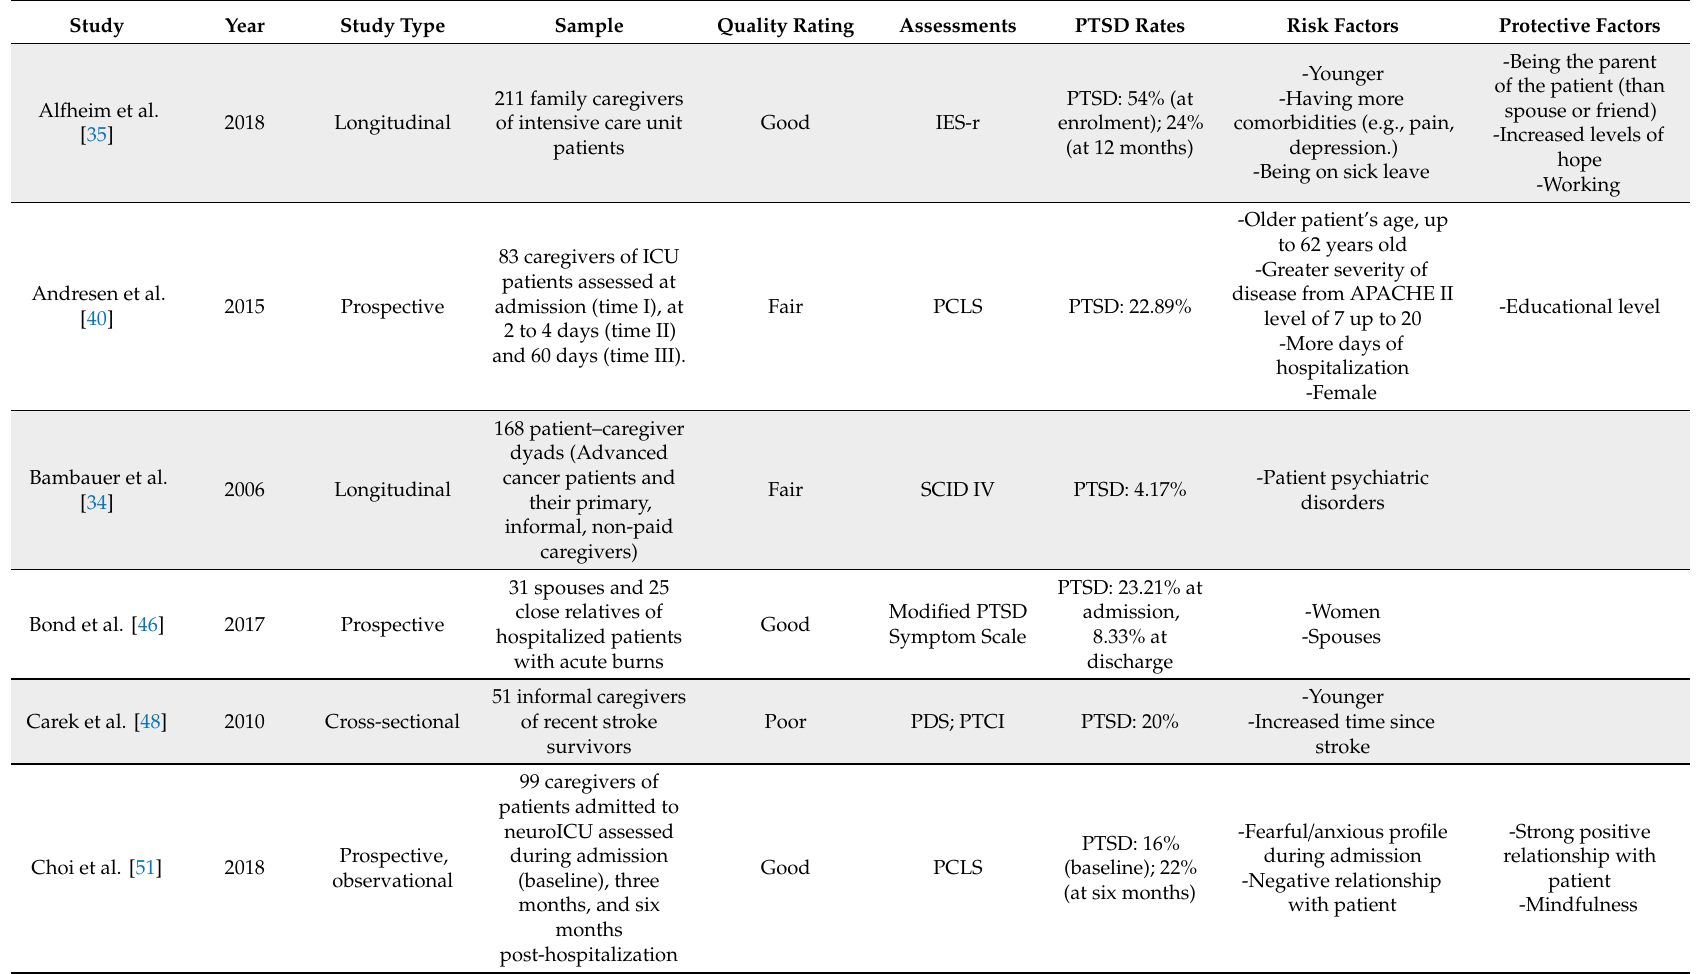
Table 1. Characteristics of included